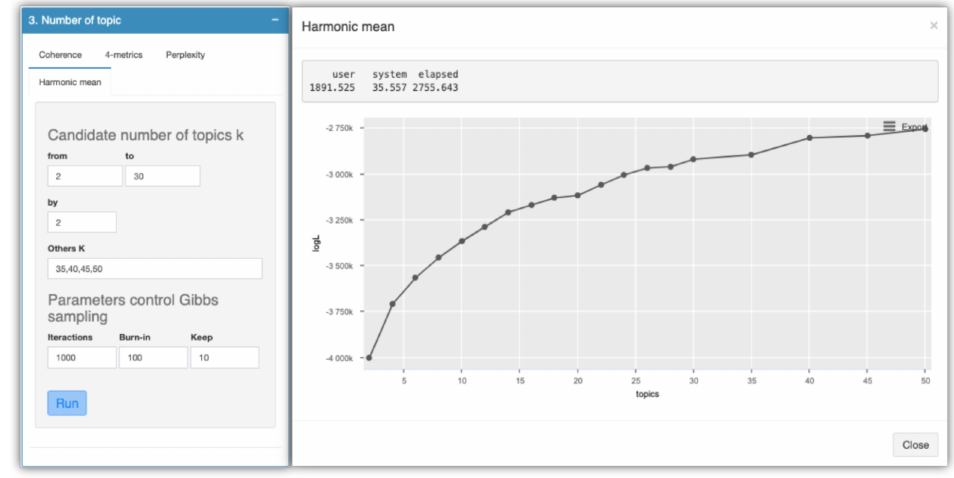
Figure 7. Configuration options used to calculate the number of topics (harmonic mean).